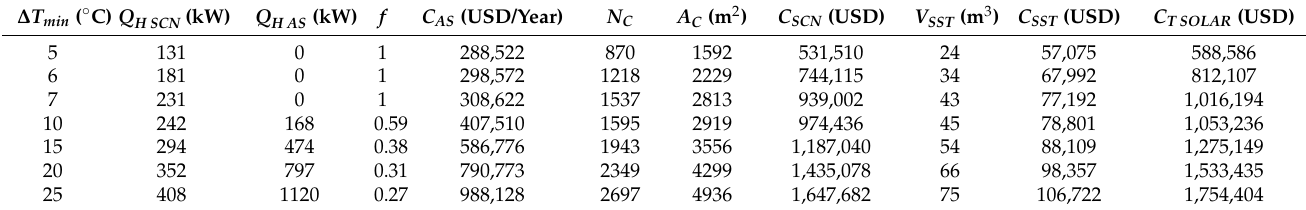
Table 10. Results of the design of the solar thermal installation for different ∆ T min .